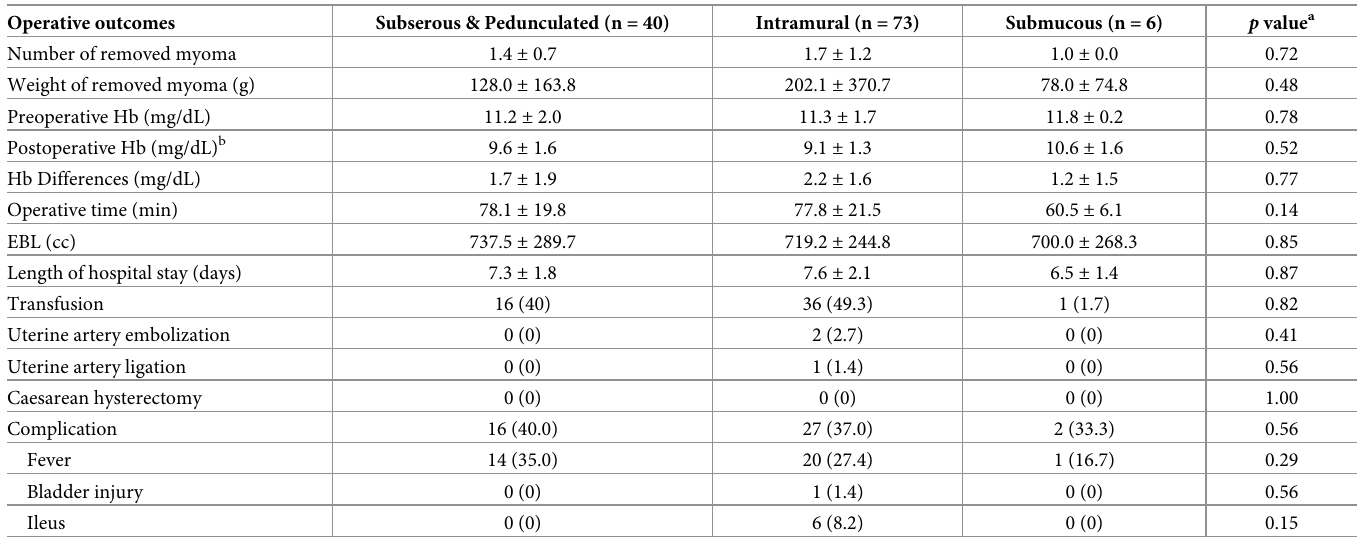
Table 7. Operative outcomes according to the myoma type in CM group (n =